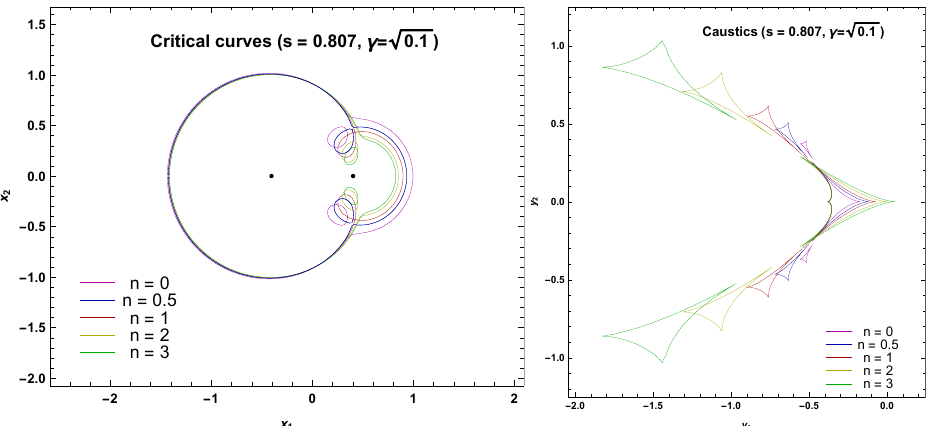
Figure 15. Critical curves and caustics in the unequal-strength binary with the standard lens on the right, close-intermediate